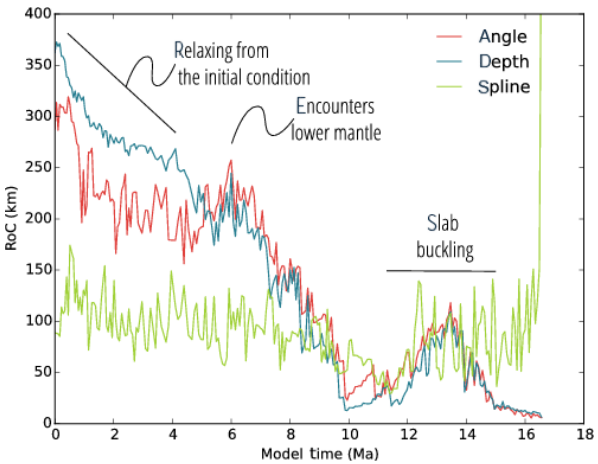
Figure 4. Radius of curvature over time for each method tested for model